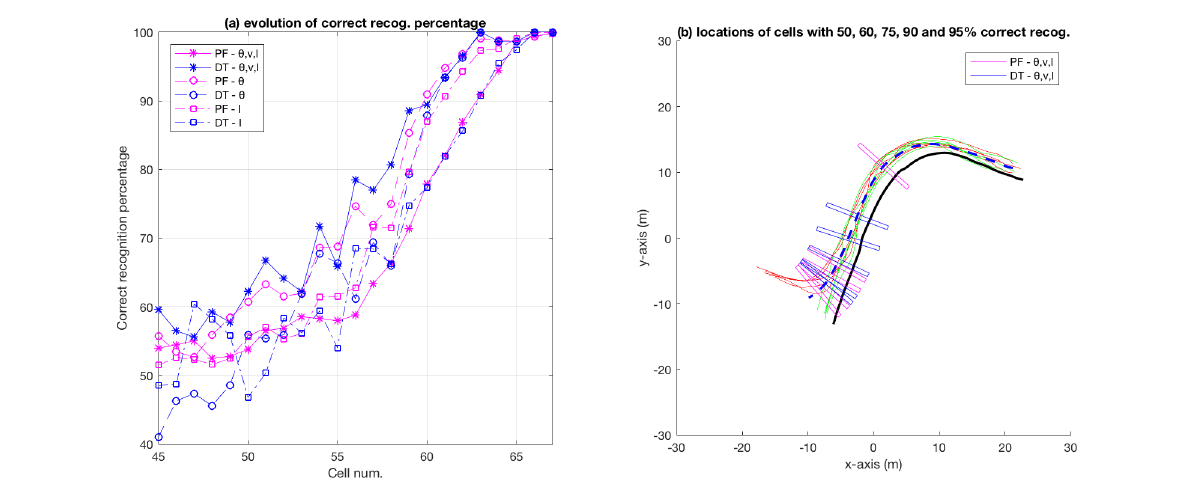
Figure 13. Evolution of correct recognition percentage along the bicycle